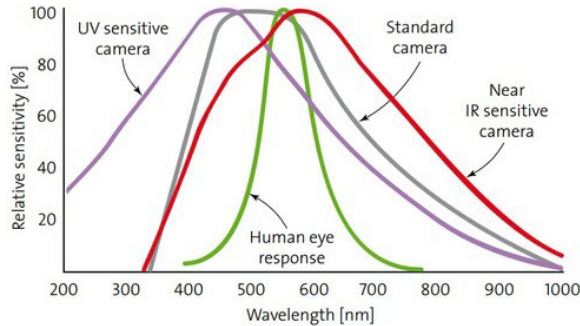
Figure 5. Comparison between a UV sensitive, standard camera, human eye responsive and near IR sensitive camera in terms of relative sensibility. (Source: https://www.stemmer-imaging.com/en/ knowledge-base/spectral-response/).